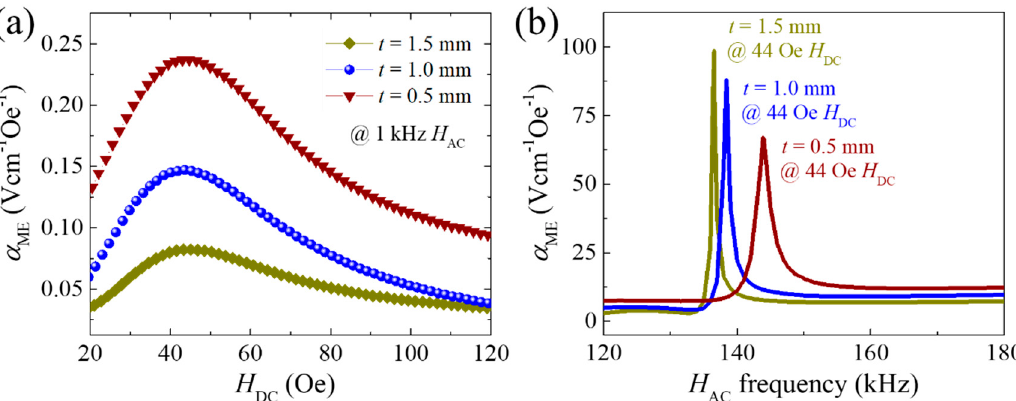
Figure 7. ( a ) Magnetoelectric voltage coe ffi cient of PZT-PMS sensors with di ff erent FE layer thicknesses measured at 1 kHz as a function of H DC . ( b ) Magnetoelectric voltage coe ffi cient spectra of the PZT-PMS sensors as a function of H AC frequency. (FE areal dimensions: 13.5 mm ( l ) × 3.0 mm ( w )).